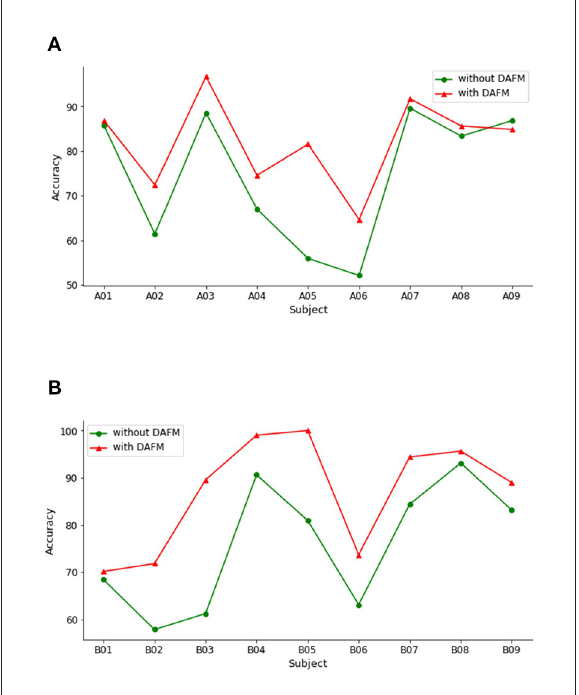
FIGURE4 Classification accuracies across subjects with or without DAFM. (A) BCI IV-2a. (B) BCI